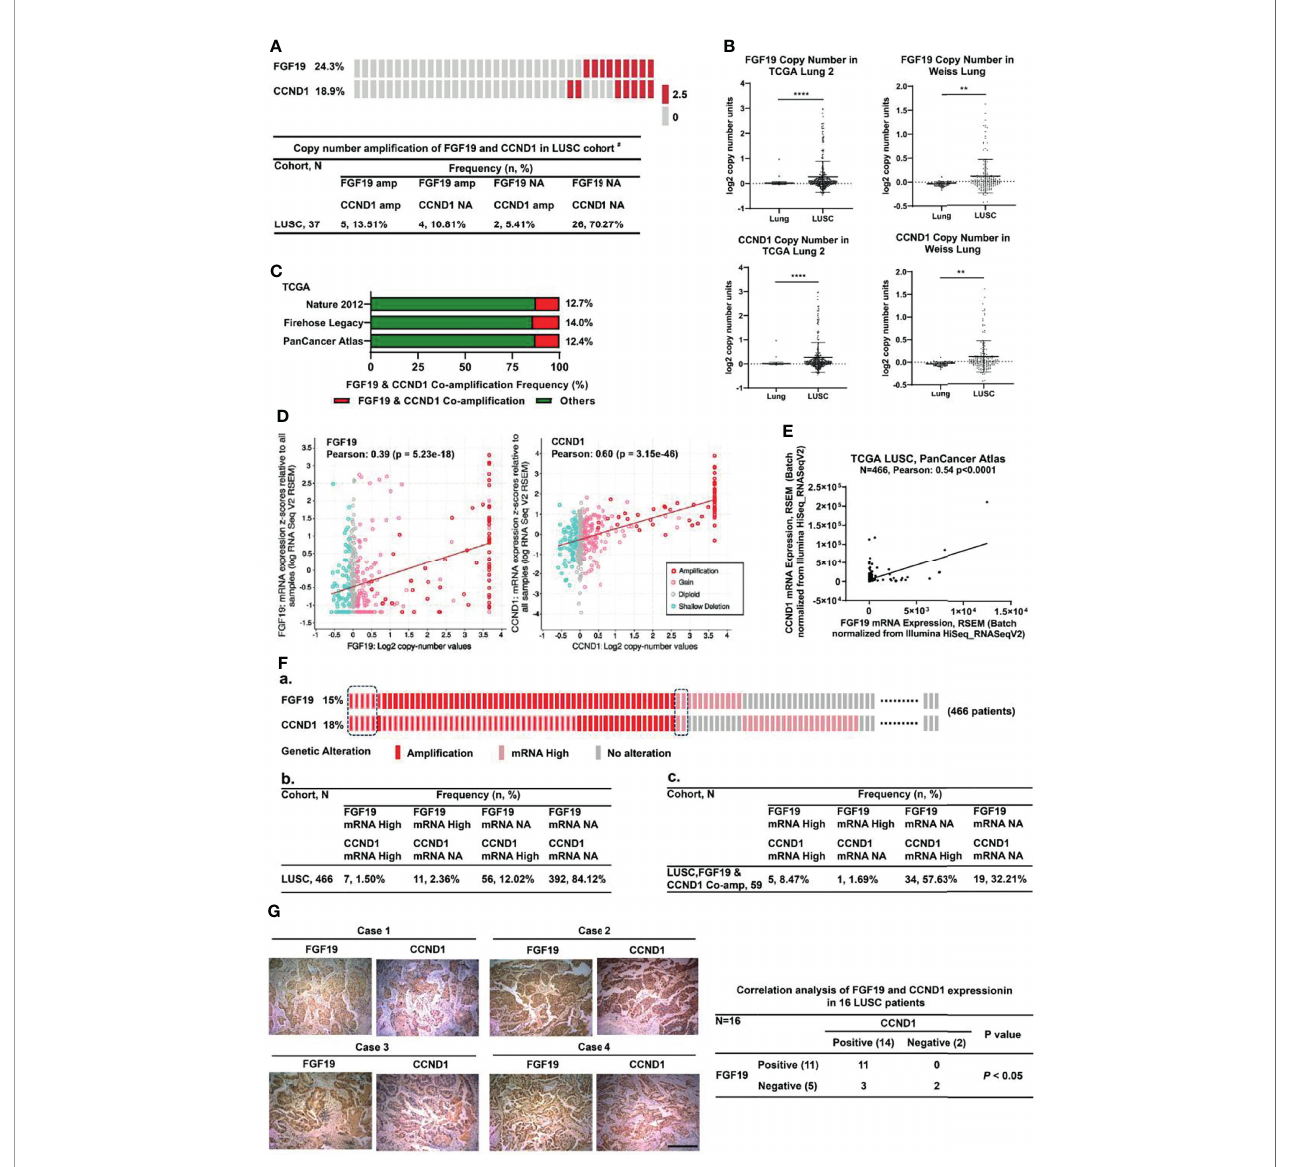
FIGURE 1 | Co-ampli fi cation and co-overexpression of FGF19 and CCND1 in human LUSC. (A) Copy number ampli fi cation distribution of FGF19 and CCND1 in our LUSC cohort # (n = 37). Co-ampli fi cation of CCND1 is common in FGF19-ampli fi ed LUSC patient in our LUSC cohort (5/9, 55.6%). #Our previous work had summarized all the clinical pathological characteristics of the samples (23). (B) Ampli fi cation of FGF19 and CCND1 is common in TCGA provisional LUSC cohort. Data were shown as mean ± SD bars and compared by unpaired t -test. ** p < 0.01 and **** p < 0.0001. (C) Co-ampli fi cation of CCND1 is common in LUSC patients in the TCGA provisional LUSC cohort, that is, 12.7% in Nature 2012, 14.0% Firehose Legacy, 12.4% PanCancer Atlas. (D) FGF19 and CCND1 gene ampli fi cation were signi fi cantly correlated with their respective expressions. (E) Linear regression and Pearson correlation of mRNA levels between FGF19 and CCND1 in the TCGA provisional LUSC cohort. Positive correlation between expression of FGF19 and CCND1 was observed. (F) Statistical analysis on the individual level based on the TCGA database (http://www. cbioportal.org). (a) Ampli fi cation and mRNA expression distribution of FGF19 and CCND1. (b, c) A 2 × 4 contingency table was generated for 2 categorical variables, FGF19 and CCND1, in 2 observation states, mRNA high and mRNA no alteration (NA); (b) Each entry represents the number of observations for a given gene in 1 observation state; (c) Entry number of observations of FGF19 and CCND1 in 1 observation state under the premise of co-ampli fi cation. (G) Positive correlation between FGF19 and CCND1 protein expression levels in the 16 LUSC tissue samples. Pearson c 2 test, P <0.001. Scale bar: 100